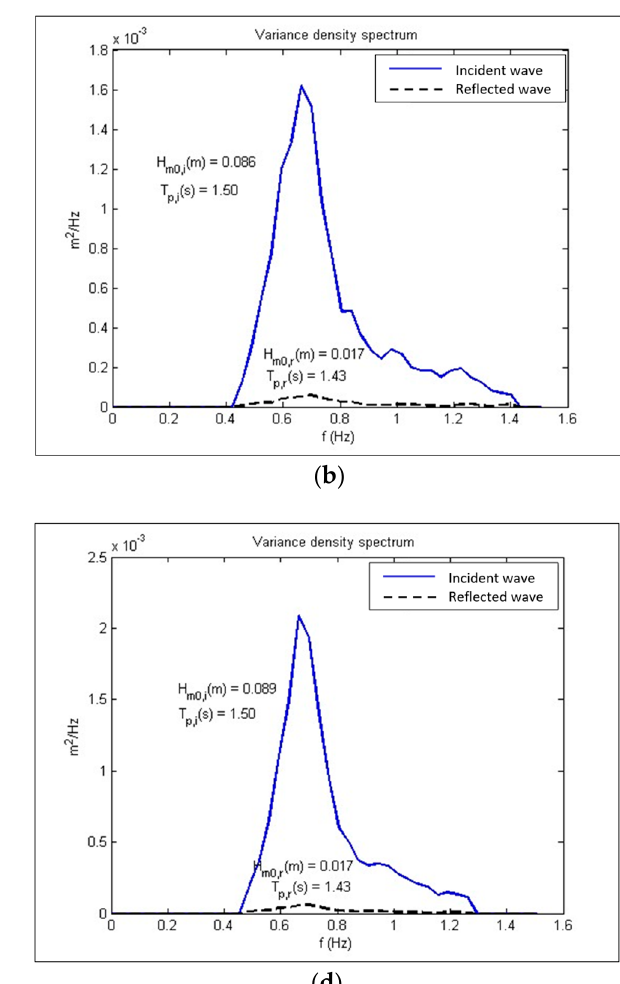
(D’Angremeond, 1997) [5], and present PTPBW.